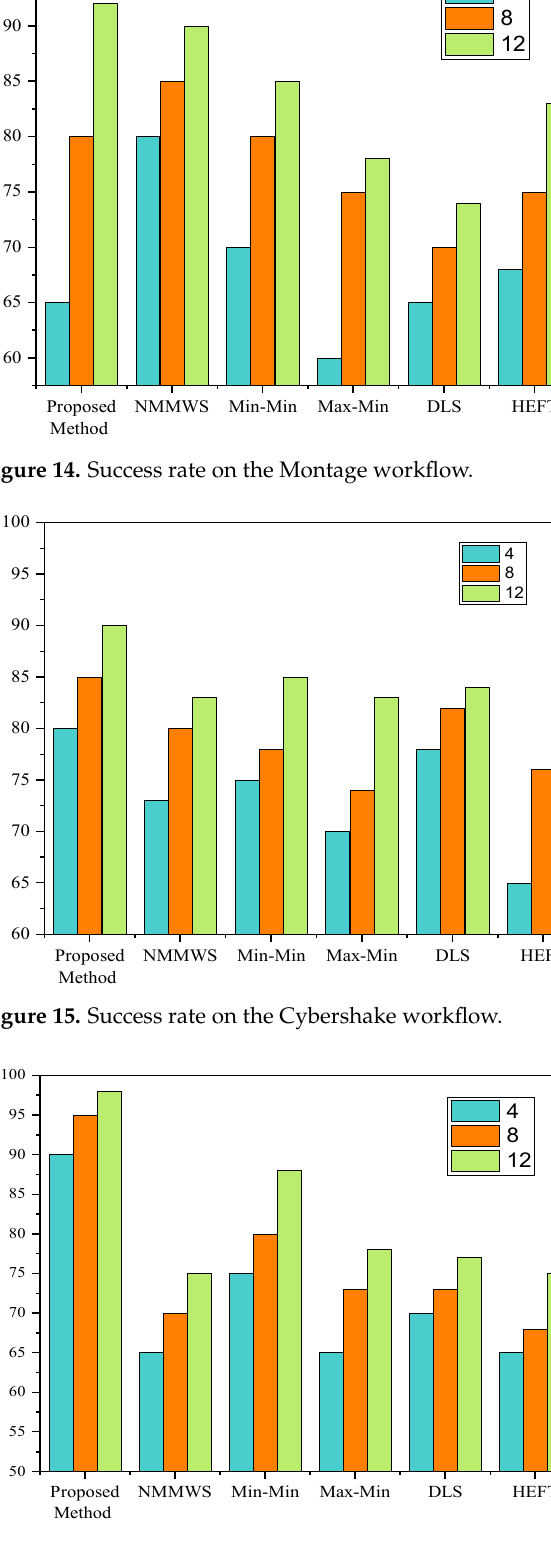
Figure 17. Success rate on the LIGO workflow.